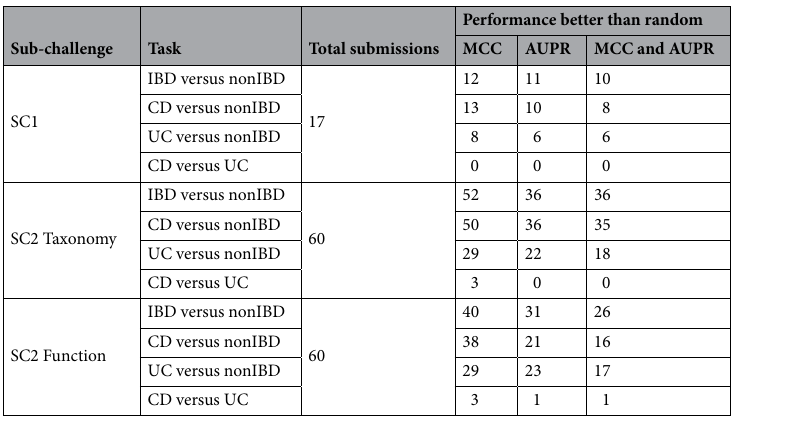
Table 1. MEDIC prediction